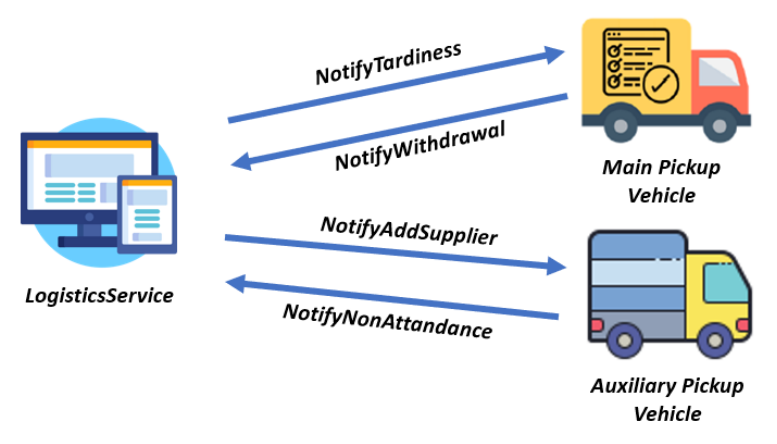
Figure 6. Supplier production line delay